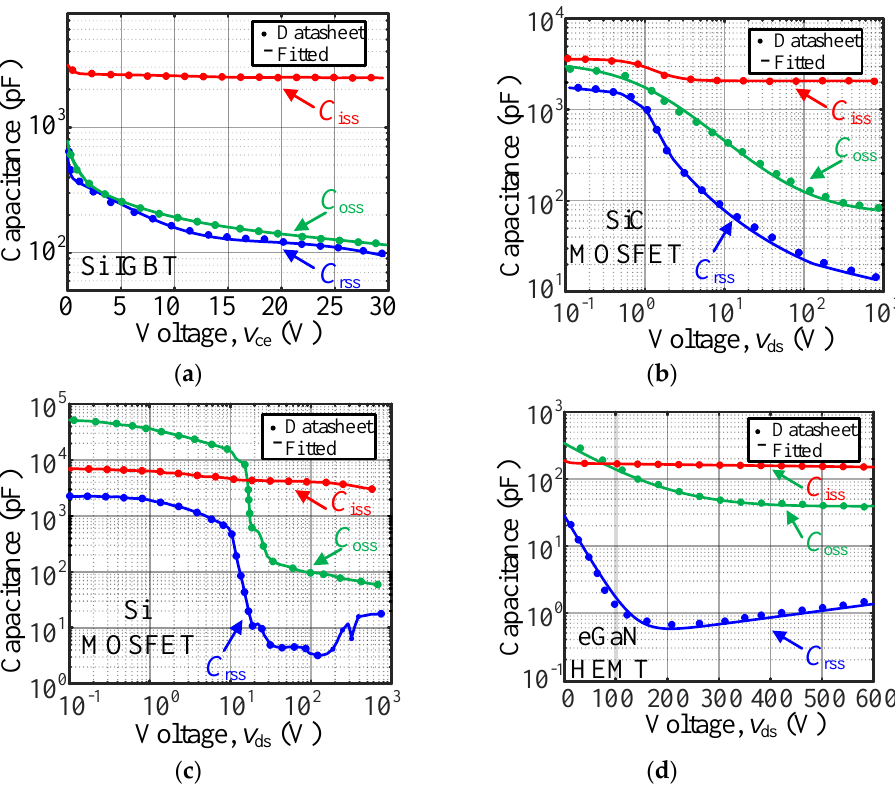
Figure 7. Parasitic capacitance extraction with the methods of ( a ) 5th order Gauss function; ( b ) Analytical equation [49]; ( c ) Interpolating look-up table (LUT); ( d ) 3rd order exponential function.